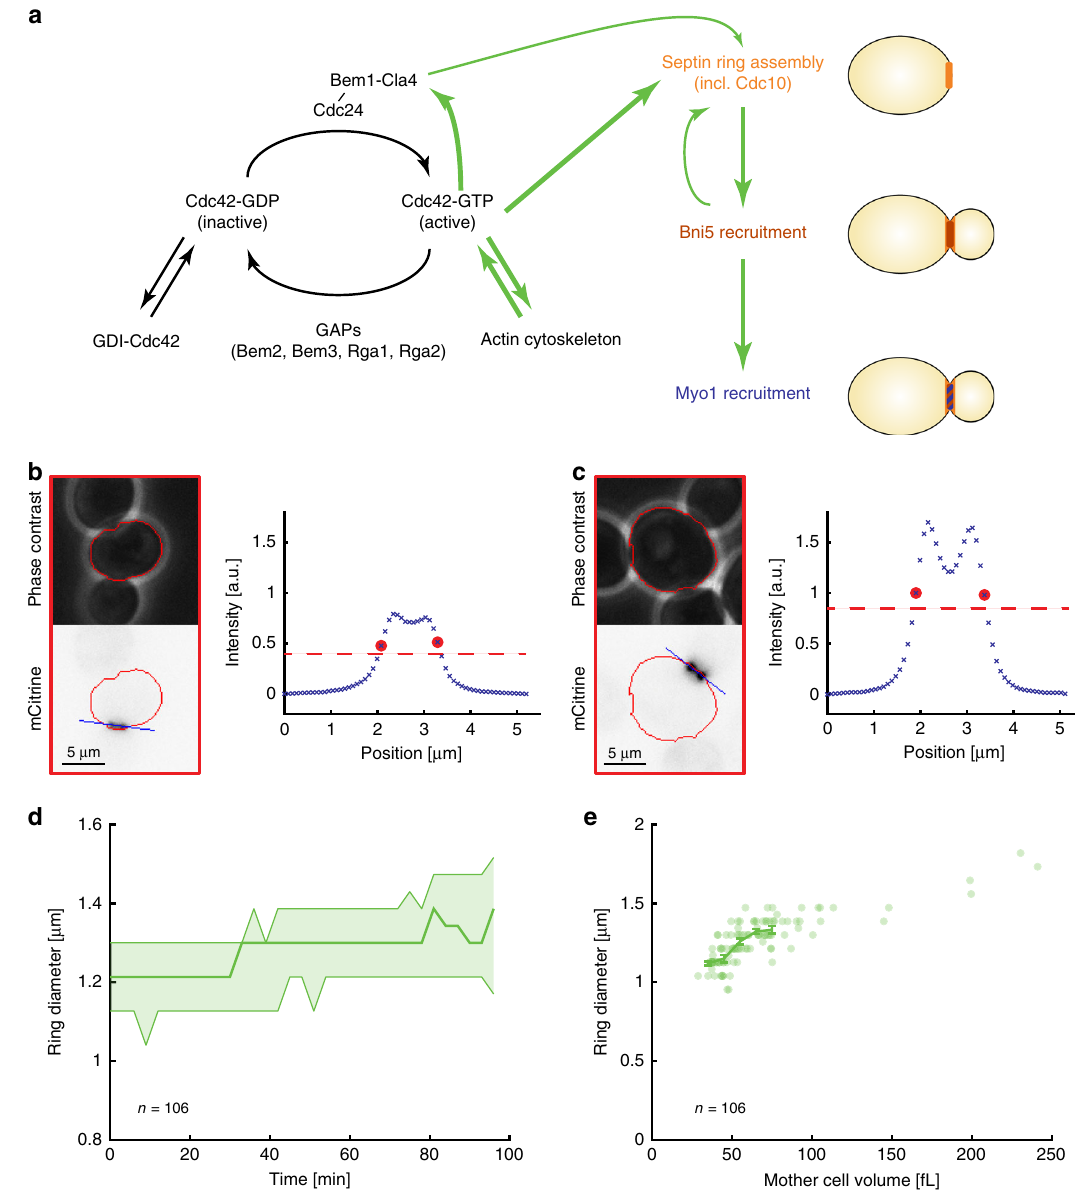
Fig. 1 Septin ring diameter increases with cell volume. a Illustration of the regulatory pathways controlling cell polarization and downstream ring assembly at the bud neck. Representative live-cell microscopy images (phase contrast (top) and Cdc10-mCitrine fl uorescence (bottom)) of a small ( b ) and big ( c ) cell 15 min before the disappearance of the septin ring. Red outline shows automated cell segmentation based on phase contrast used to estimate cell volume. Blue shows the automatically determined line parallel to the ring used to estimate ring diameter. The corresponding fl uorescence intensity pro fi les after applying gliding average and background subtraction are shown for both cells. Red circles show positions used to estimate septin ring diameter, dashed red lines denote half maximum. d The median ring diameter (thick line) as quanti fi ed from Cdc10-mCitrine fl uorescence signal is shown as a function of the time since the fi rst frame where the ring was detected for analysis. Error bars show 25 and 75 percentiles. Data for a total of 106 cells pooled from three independent experiments are shown for the time range during which a ring was detected for at least 15 cells. e For each cell ( n = 106), the median ring diameter during the time when the ring is detected is shown as a function of the median cell volume during that time. Raw data are shown in Supplementary Fig. 1f. Error bars denote means and standard errors. Cells were grown on SCGE. Source data are provided as a Source Data fi